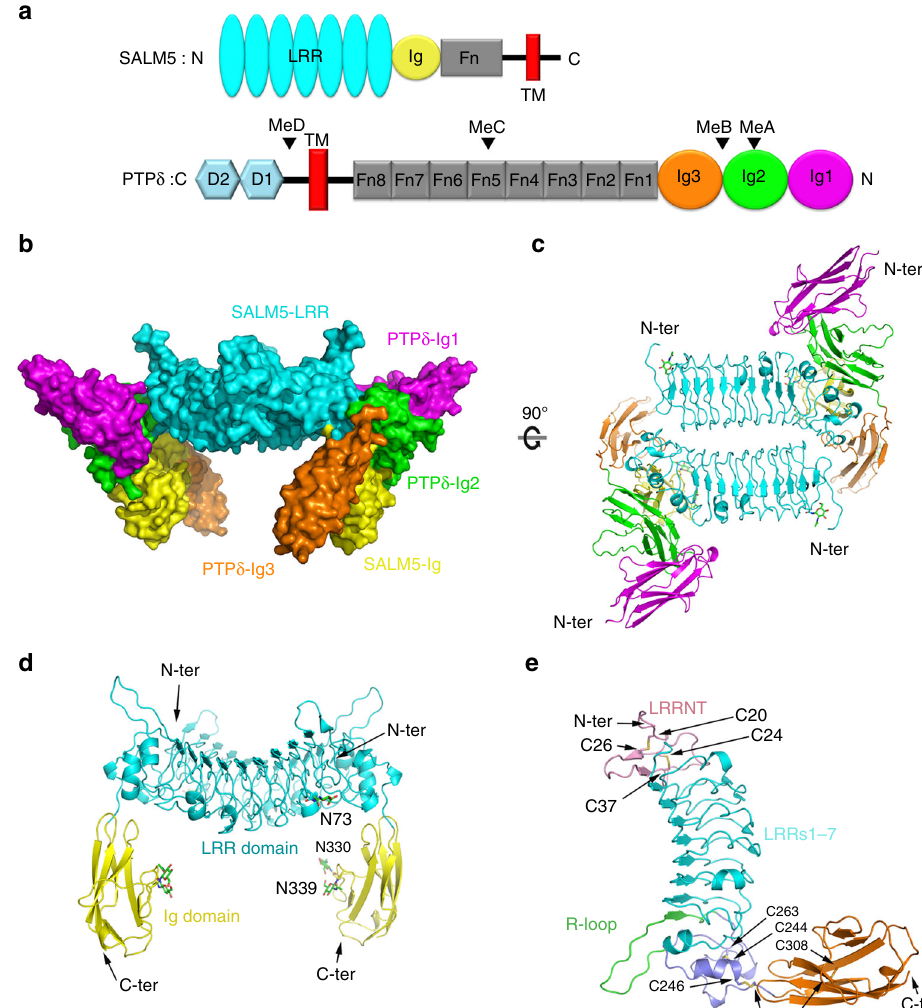
Fig. 1 Overall structures of the 2:2 heterotetrameric SALM5/PTP δ complex, SALM5 dimer, and monomer. a Domain organization of human SALM5 and human PTP δ . LRR: leucine-rich repeats domain; Ig: Ig-like domain; Fn: fi bronectin type III domain; D1, D2: a tandem of tyrosine – protein phosphatase domains; Me: mini exon; TM: transmembrane domain; N: N-terminus; C: C-terminus. b Surface representation of the dimeric SALM5/PTP δ complex. The LRR domain and Ig domain in SALM5 are colored cyan and yellow, respectively. The Ig1, Ig2, and Ig3 domains in PTP δ are colored magenta, green, and orange, respectively. c Top view of the dimeric SALM5/PTP δ complex shown in ribbons. d Side view of the SALM5 dimer (extracted from PTP δ -bound complex structure) in ribbons. e Ribbon representation of SALM5 LRR-Ig domains. Disul fi de bonds are indicated using yellow sticks. Color codes are as follows: LRRNT, pink; LRRs 1 – 7, cyan; LRRNT, slate; R-loop, green; Ig domain, orange. c , d The N-linked glycans are indicated as sticks, and three glycosylation sites (N73, N330, and N339) of one SALM5 molecule are labeled. The N and C terminus of each molecule are, respectively, labeled as “